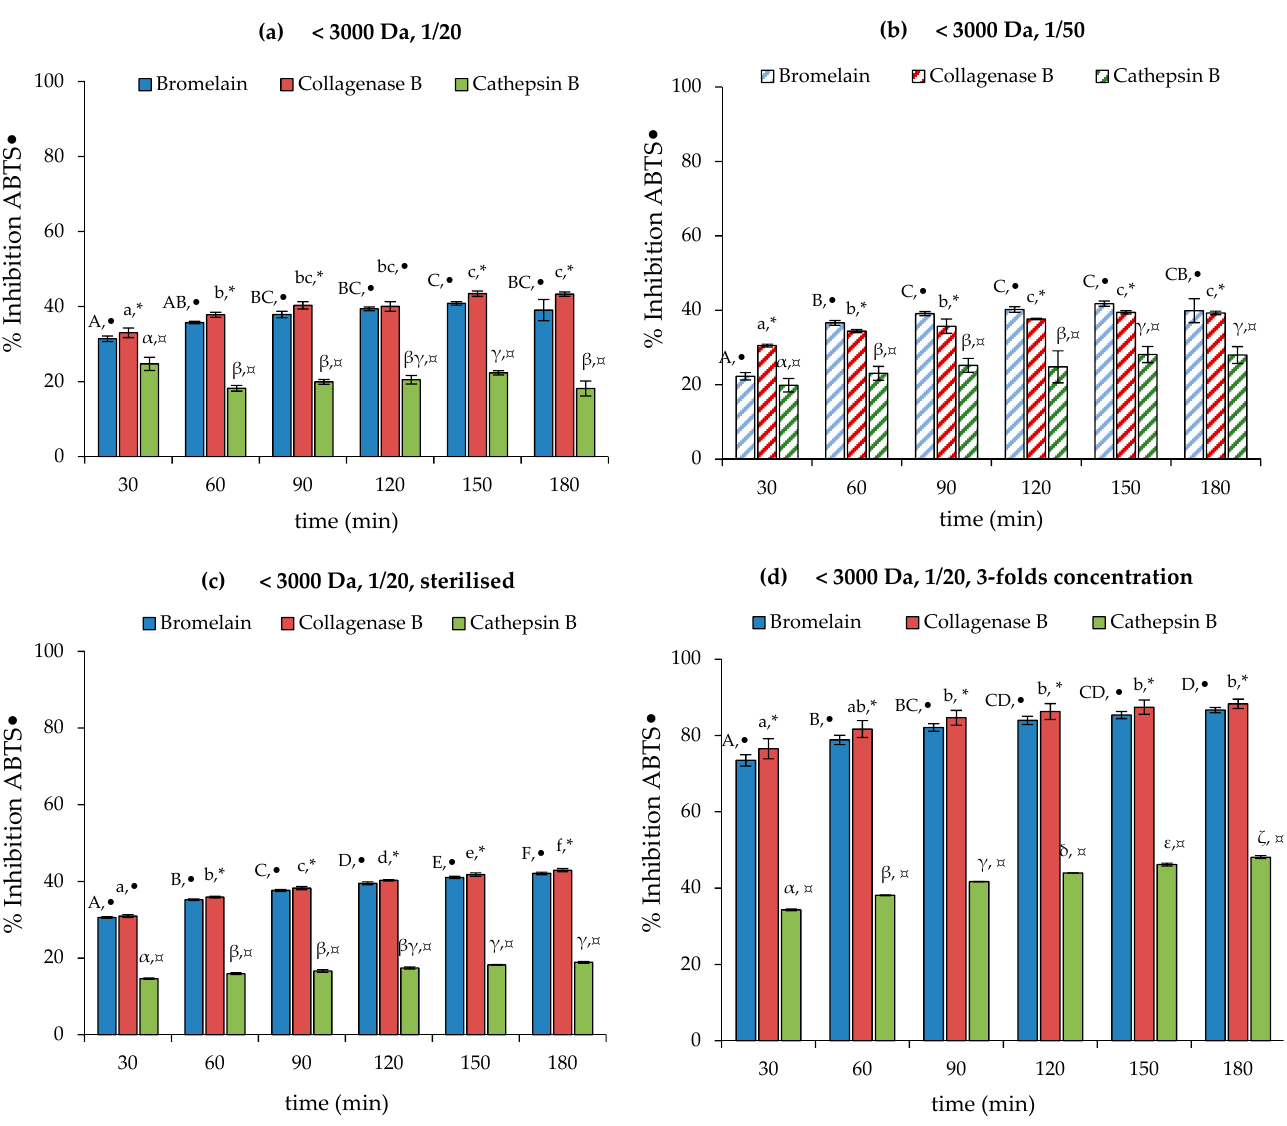
Figure 3. Percentage of inhibition of the ABTS• + by the peptides-minerals complexes, for the < 3000 Da fraction and for the ratio E:C 1/20 ( a ) and 1:50 ( b ); for the <3000 Da fraction, E:C 1/20, after sterilization ( c ); for the <3000 Da fraction, E:C 1/20, after 3-folds concentration ( d ). Columns label interpretation: (i) different uppercase letters indicate differences over time for complexes obtained by bromelain; (ii) different lowercase letters indicate differences over time for complexes obtained by collagenase B; (iii) different Greek letters indicate differences over time for complexes obtained by cathepsin B; (iv) different symbols indicate differences among peptide-mineral complexes according to the enzyme.